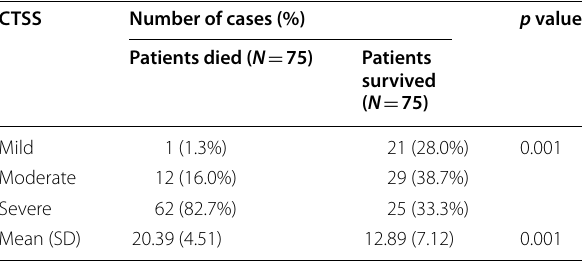
Table 6 Distribution of cases according to CT severity score and survival ( N 150) =